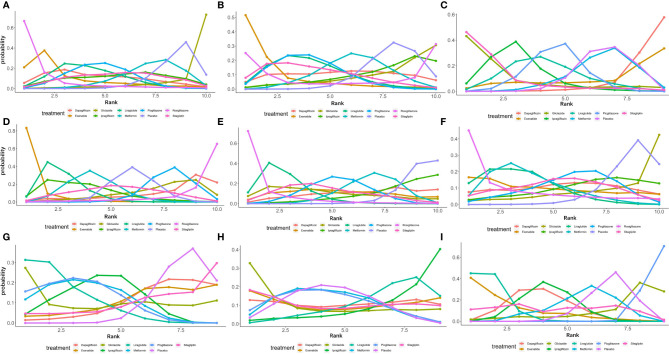
Ranking probabilities of different hypoglycemic agents for different outcome indicators. (A) Ranking probability of different hypoglycemic agents on ALT. (B) Ranking probability of different hypoglycemic agents on AST. (C) Ranking probability of different hypoglycemic agents on Triglyceride. (D) Ranking probability of different hypoglycemic agents on BMI. (E) Ranking probability of different hypoglycemic agents on FPG. (F) Ranking probability of different hypoglycemic agents on HbA1c. (G) Ranking probability of different hypoglycemic agents on HDL. (H) Ranking probability of different hypoglycemic agents on LDL. (I) Ranking probability of different hypoglycemic agents on Weight.